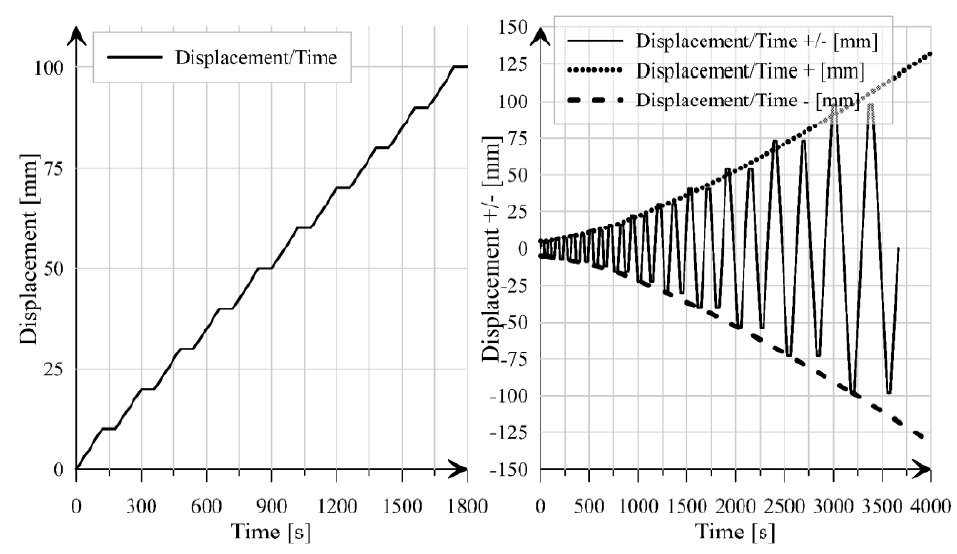
Figure 5. Load input curves by displacement control; left: monotonous load; right: cyclic load.